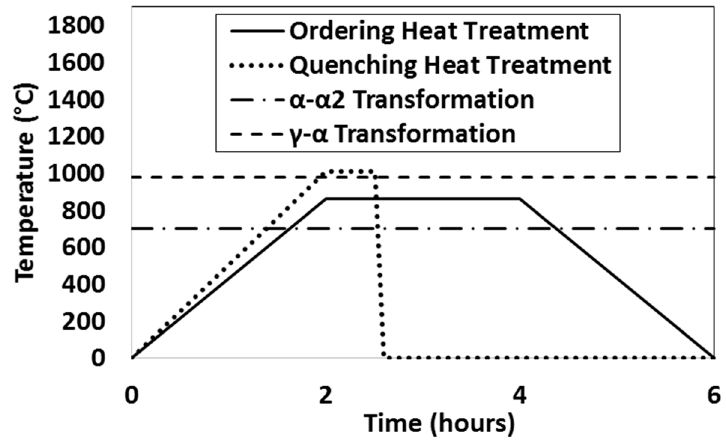
Figure 1. Ordering and quenching heat treatment schedules.